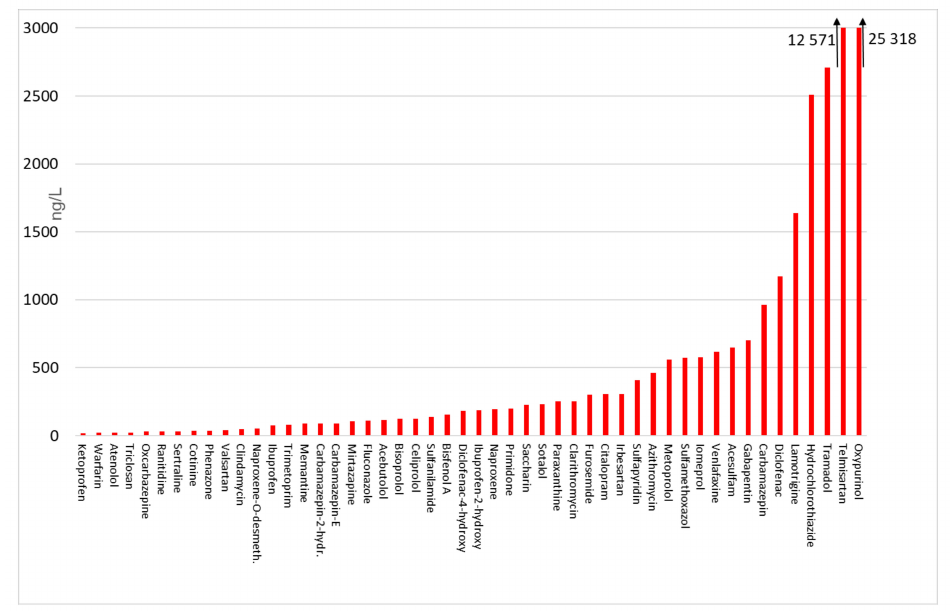
Figure 3. Average content of pharmaceuticals and personal care products (PPCPs) that are systematically discharged from the wastewater treatment plant in Mlad á Boleslav.